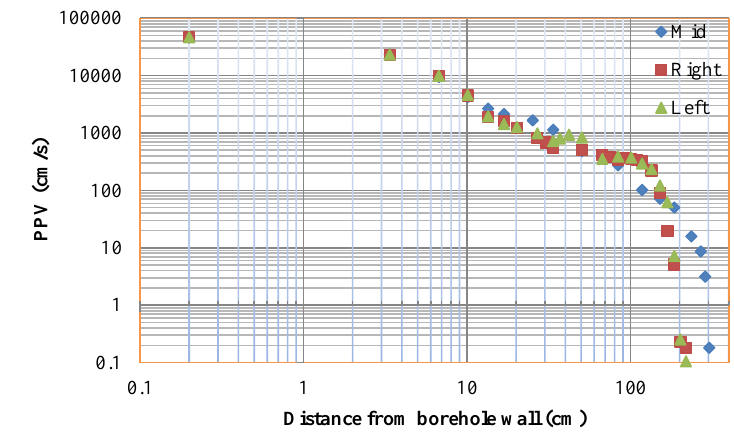
Figure 17. Presentation of peak particle velocities (PPVs) obtained from numerical study on a log-log scale. Appl. Sci. 2018 , 8 , x FOR PEER REVIEW